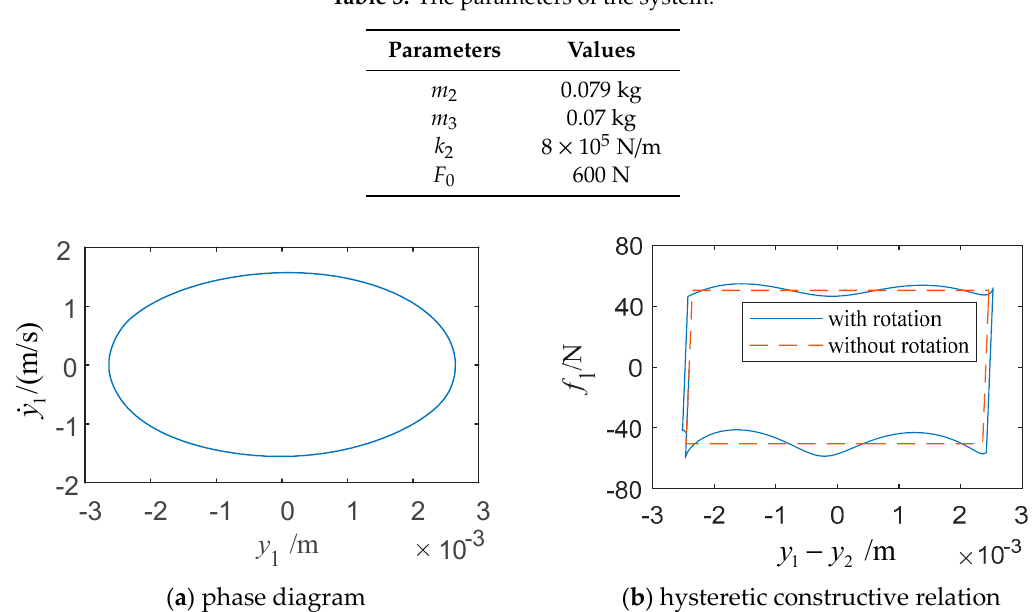
Figure 7. Phase diagram ( a ) and the hysteretic constructive relationship of f 1 and y 1 − y 2 ( b ) when the system reaches